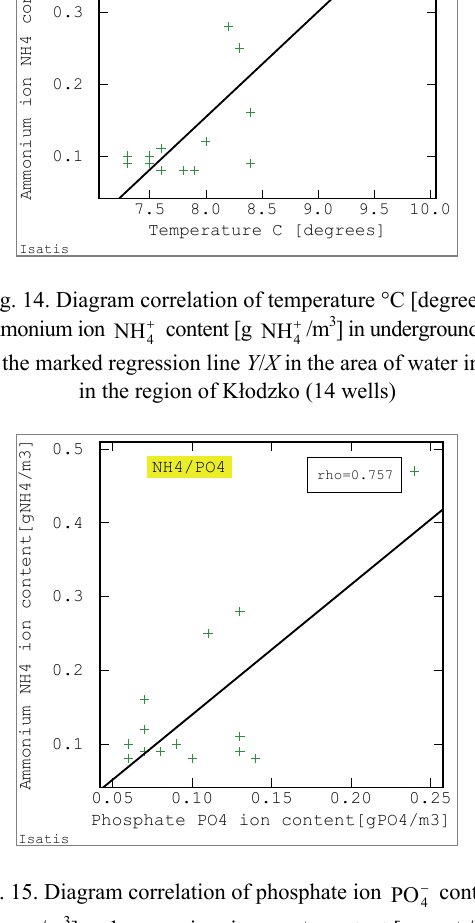
Fig. 12. Diagram correlation of manganese Mn ++ content [g Mn ++ /m 3 ] and total organic coal C (OWO) [gC/m 3 ] in underground water, with the marked regression line Y / X in the area of water intake in the region of Kłodzko (14 wells)